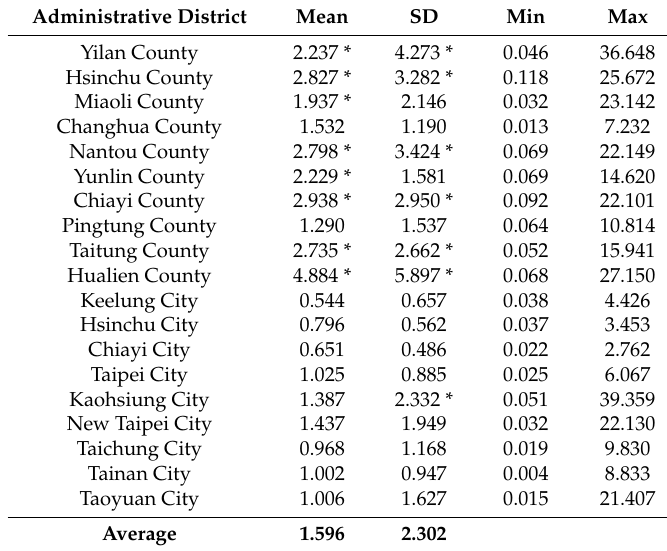
Table 4. Summary statistics of the nearest road distance (in kms) of community care centers as determined by method M1.